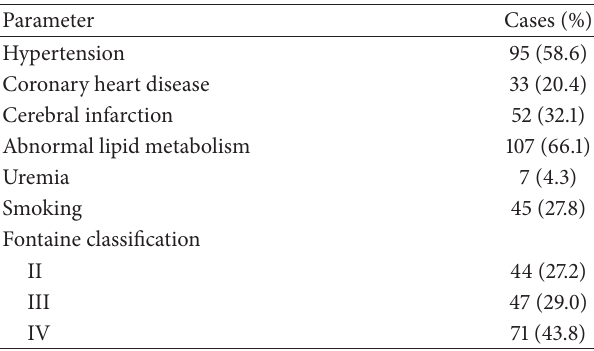
Table 1: General condition of 162 diabetic patients.